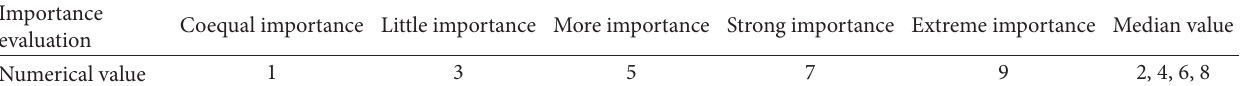
Table 1: Proportional